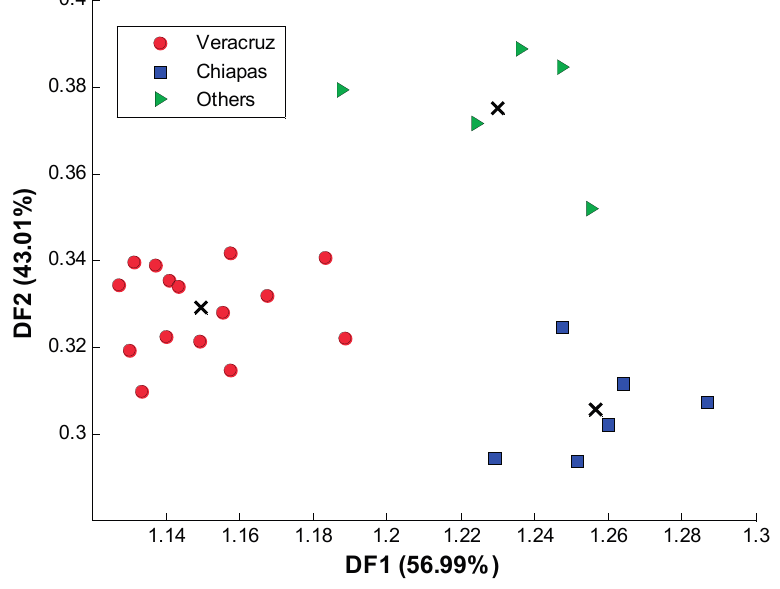
Figure 7. Class distribution achieved by LDA for geographical origin of